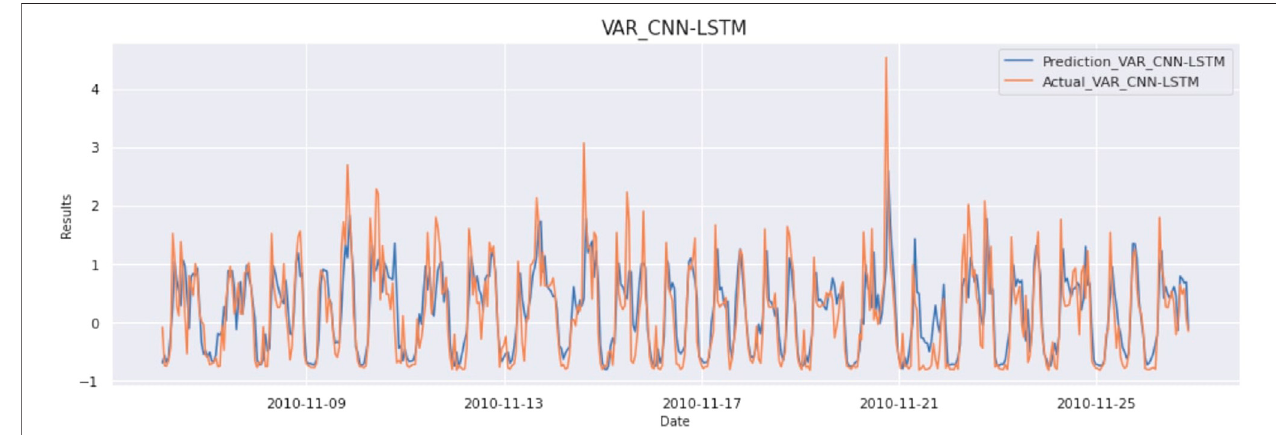
FIGURE 4 | Prediction vs Actual result of VAR CNN-LSTM model (Household Electricity Data).